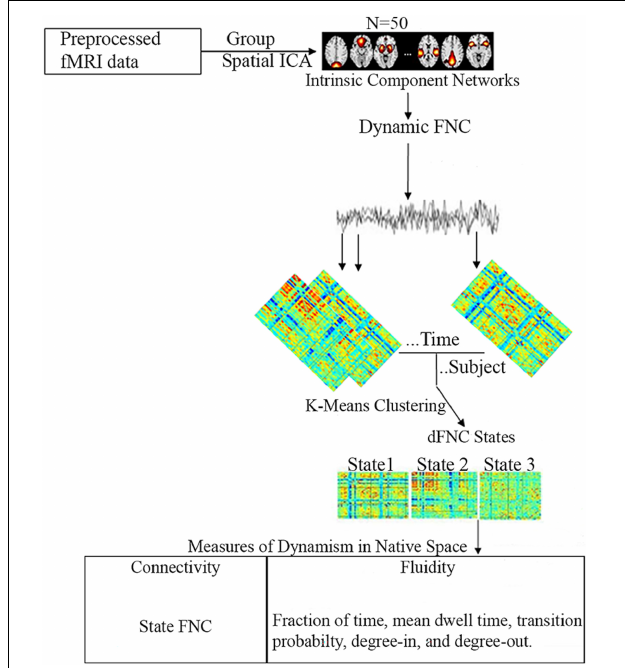
FIGURE 1 | Schematic diagram of the analysis pipeline. Rs-fMRI data was preprocessed and subjected to spatial group ICA resulting in 50 intrinsic component networks. Static FNC was then estimated. For dFNC, the sliding window approach was adopted and clustered using K-means to obtain 3 cluster states. Based on these three cluster states, five measures of dynamism were computed in native